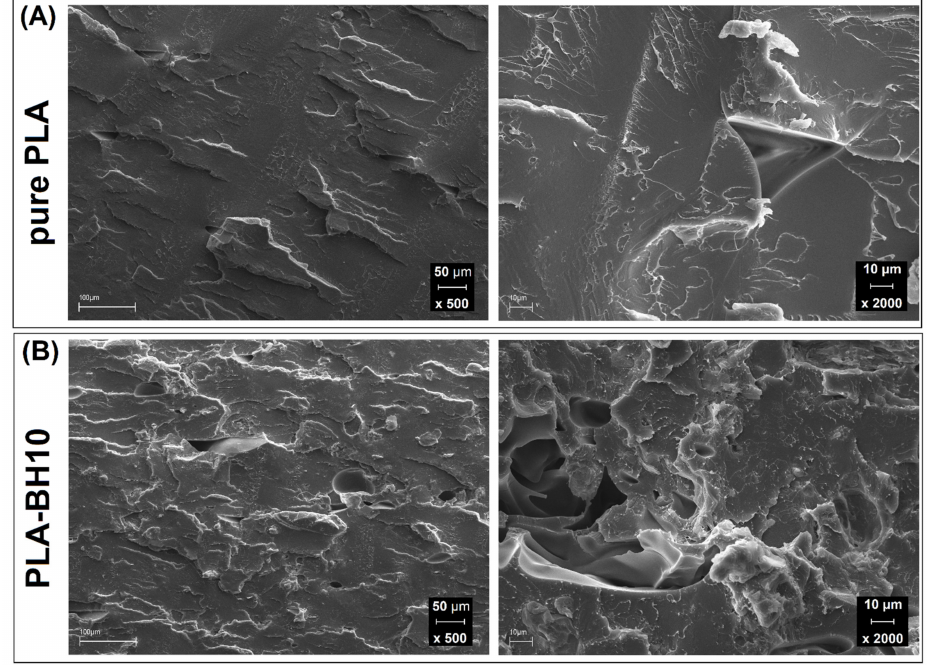
Figure 15. SEM pictures presenting the structure of ( A ) pure PLA printed sample and ( B ) PLA-BH10 printed